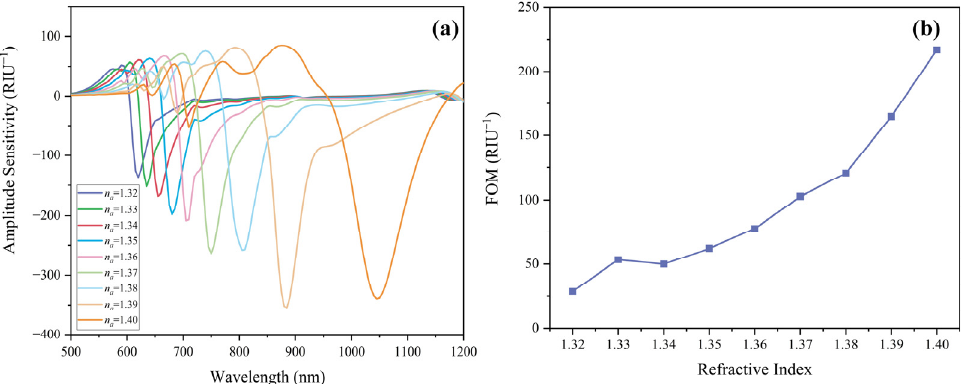
Figure 5. ( a ) Amplitude sensitivity and ( b ) figure of merit with analyte RI changing from 1.32 to 1.41.